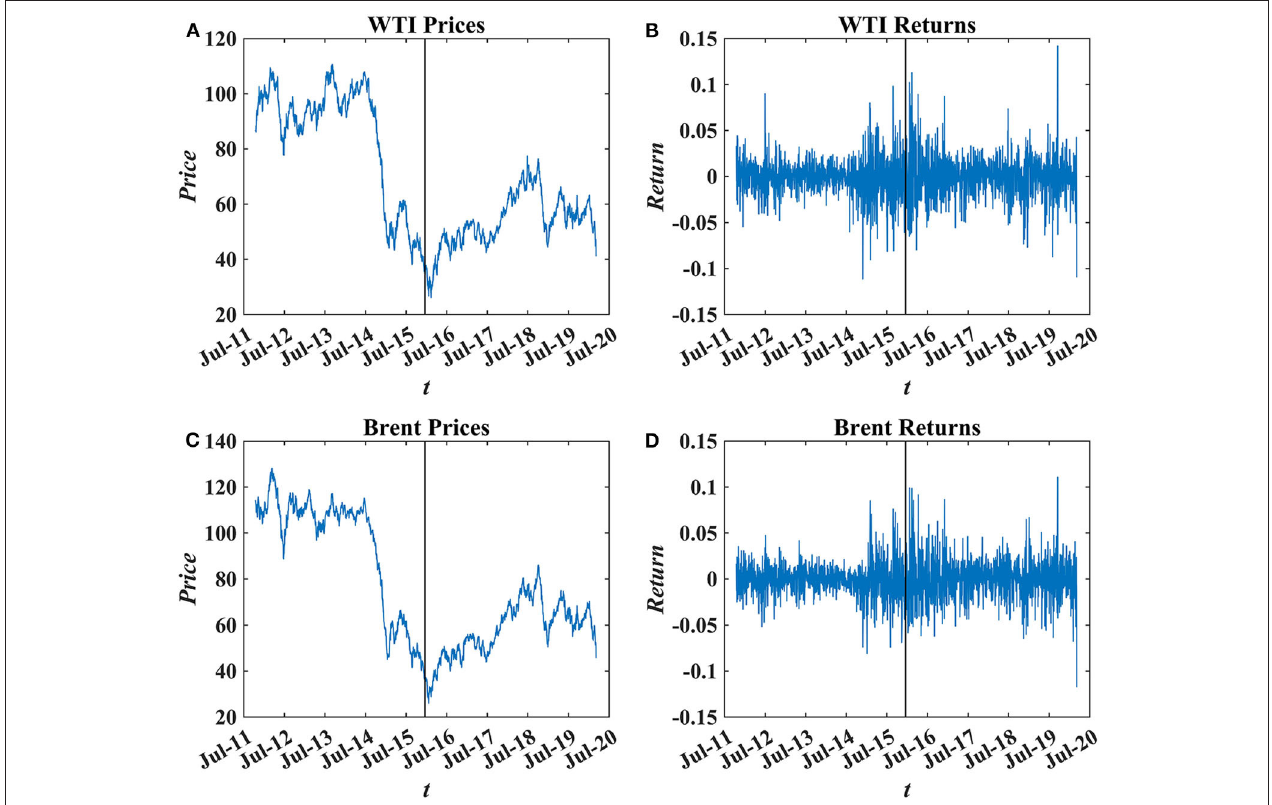
FIGURE 1 | The daily spot prices and returns for WTI and Brent. The vertical line marks the lift of the export ban. (A) WTI prices. (B) WTI returns. (C) Brent prices. (D) Brent